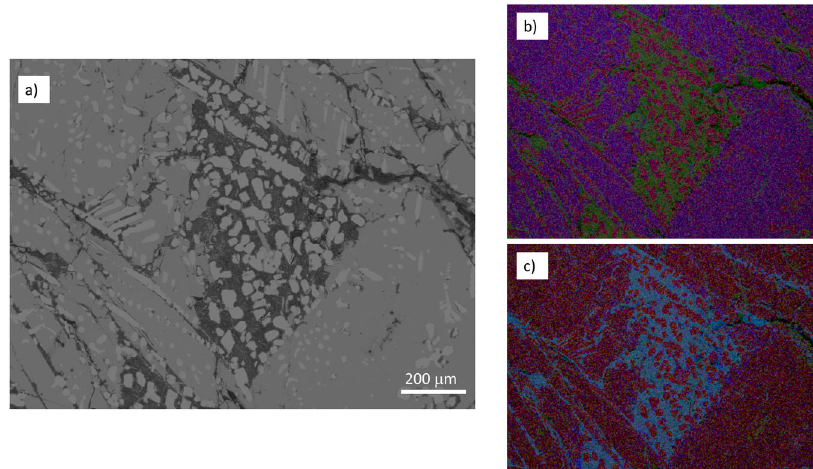
Fig. 6 Elemental maps of the Ca – P – O material. The Ca – P – O material (BSE image in a ) is shown in three-element RGB maps, with ( b ) Fe as red, O as green, and Si as blue, and ( c ) Fe as red, O as green, and P as blue. The Ca – P – O material is associated with some Si and O, suggesting its formation may be coupled to FeSi or FeSi 2